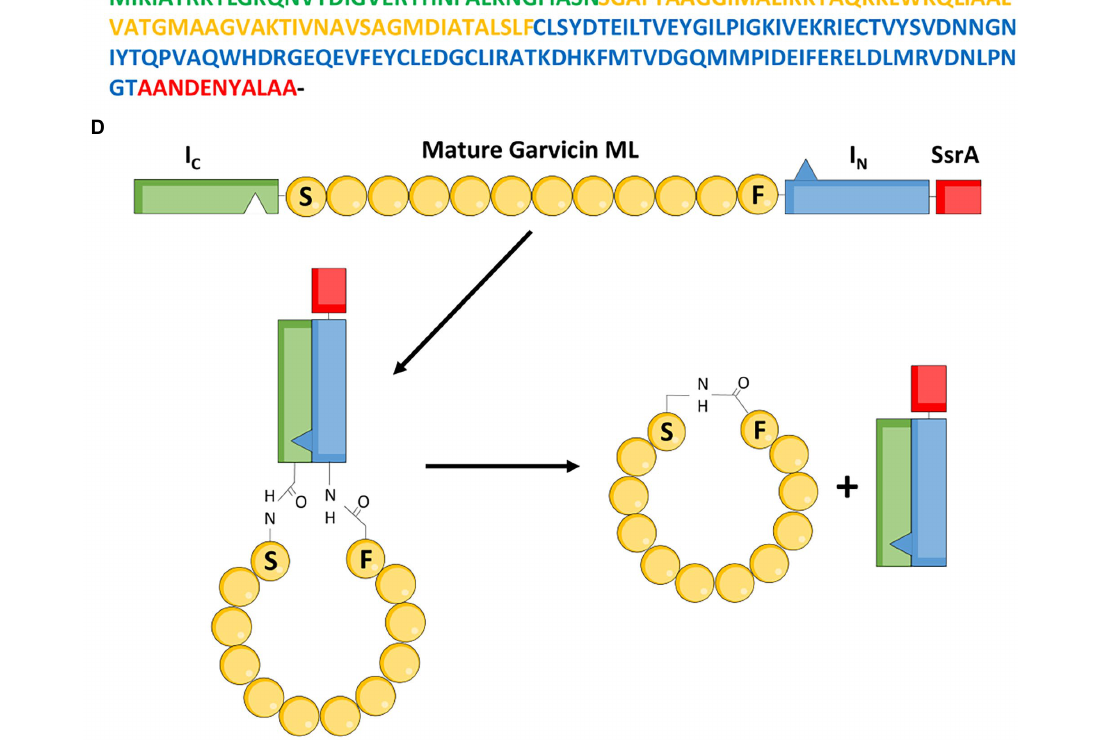
FIGURE 1 Garvicin ML circularization by the split-intein mediated ligation (SMIL) of peptides and proteins. (A) Amino acid sequence of mature GarML; the amino acids implicated in the head-to-tail circularization of native GarML, in red, and the amino acids selected for the IV-CFPS and SIML and the in vivo production and circularization of GarML, in blue. (B) Schematic representation of the pUC-derived protein expression vectors encoding the Npu-GarML, GarML and Npu mut -GarML gene products. (C) Amino acid sequence of the construct I c -GarML-I N -SsrA encoded by pCirc-Npu- GarML; the C-terminal-36-amino acid sequence (I c ) and the N-terminal-104-amino acid sequence (I N ) of the Npu split intein are shown in green and blue, respectively; the GarML sequence is in yellow and the SsrA sequence in red. (D) Schematic representation of the cyclization process of GarML; the intein peptides, I N and I c , interact to form an active peptide that splices including circularization of mature